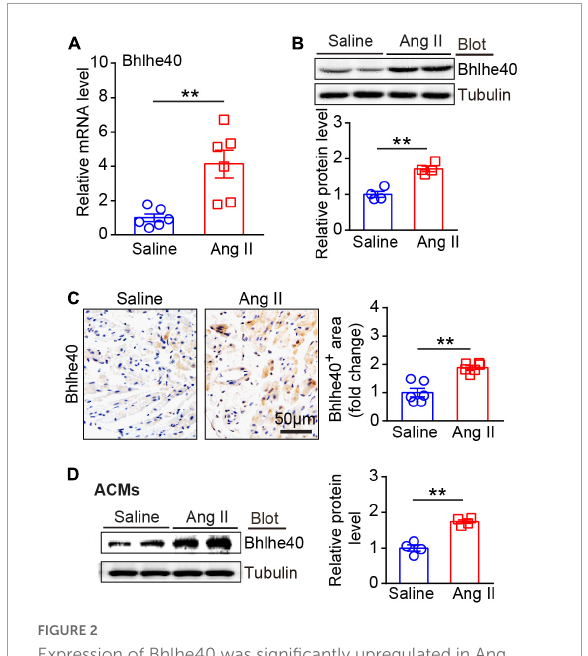
FIGURE2 Expression of Bhlhe40 was significantly upregulated in Ang II-induced atrial tissues and atrial myocytes. (A) qPCR analysis of the mRNA level of Bhlhe40 in Ang II-infused or saline-infused atrial tissues ( n = 6). (B) Immunoblotting analysis of Bhlhe40 expression in atrial tissues from each group (upper), and quantification of the Bhlhe40 level (lower, n = 4). (C) IHC staining of Bhlhe40 (left) and the quantification of the Bhlhe40-positive area (right) in atrial tissues from Ang II-infused or saline-infused mice ( n = 6). Scale bar = 50 µ m. (D) primary atrial cardiomyocytes (ACMs) were treated with Ang II (100 nM) or Saline for 24 h. Bhlhe40 protein levels in ACMs were detected by immunoblotting analysis (left) and quantified (right) ( n = 4). ** P < 0.01 vs saline-treated WT